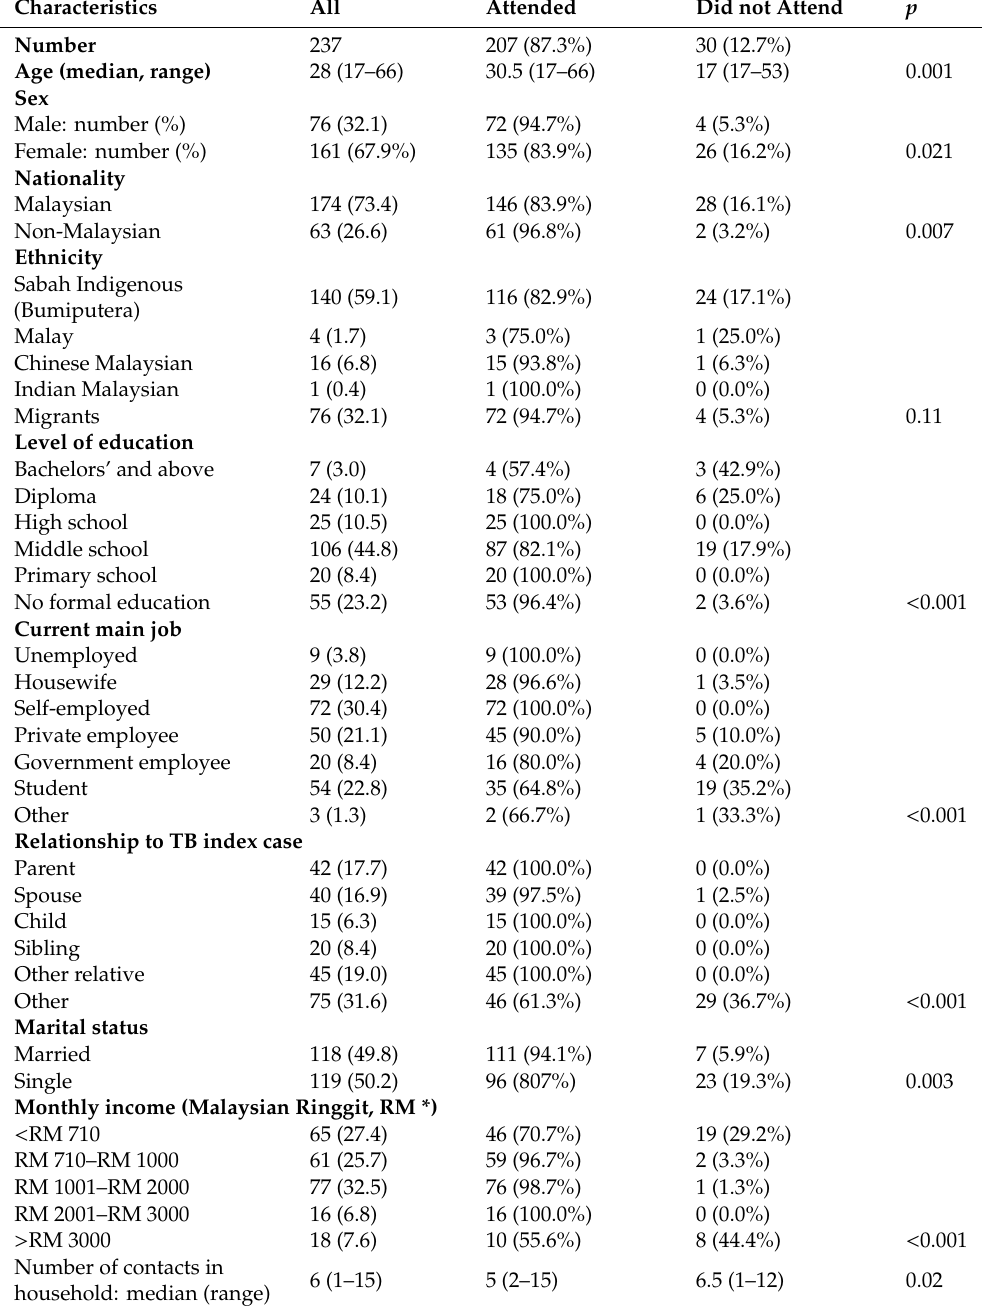
Table 1. Demographic characteristics among attending and non-attending study